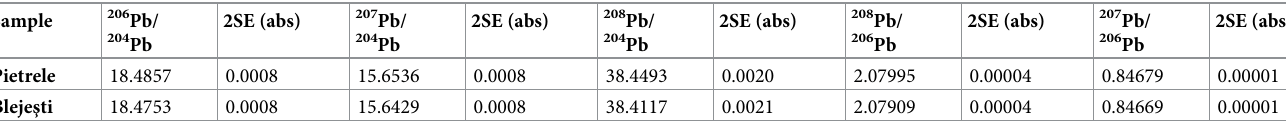
Table 7. Lead isotope ratios in the Bleje ş ti 1–2 and Pietrele P06F3741096 samples analyzed by MC-ICP-MS. Sample